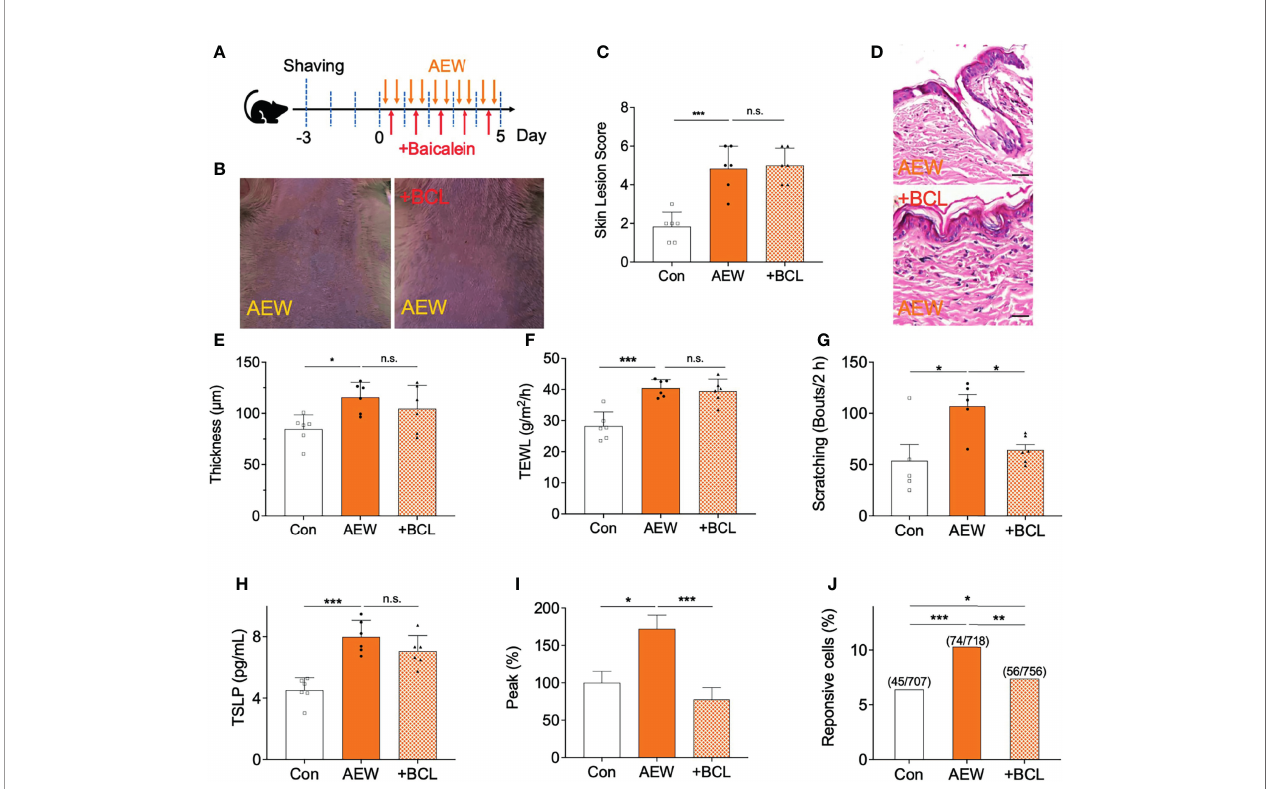
FIGURE 7 | Administration of a TSLPR antagonist reduced scratching behaviors in AEW-treated mice. (A) A schematic illustration depicting the administration of baicalein (BCL) during treatment with AEW. (B) Pretreatment with BCL did not alleviate the overall skin conditions following AEW treatment. (C) The skin lesion scores are not reduced in the BCL-treated AEW mice on day 5 (n = 6). (D) Representative H&E-stained images of the skin lesions of AEW-treated mice with or without BCL administration. (E) The thickness of the epidermis did not change in the skin lesions of the BCL-treated AEW mice (n = 6) (F) The values of TEWL were not altered in the BCL-treated AEW mice on day 5 (n = 6). (G) The spontaneous scratching bouts were signi fi cantly reduced in the BCL-treated AEW mice (n = 6), compared to those of the AEW mice (n = 6). (H) The serum levels of TSLP did not decrease in the BCL-treated AEW mice (n = 6), compared to those of the AEW- treated mice (n = 6). (I) The TSLP-induced responses of the DRG neurons from BCL-treated AEW mice (n = 56) revealed that the peak responses were signi fi cantly reduced in comparison to those of the AEW mice (n = 76). (J) The percentage of TSLP-responsive neurons in BCL-treated AEW mice (7.4%, 56 out of total 756 neurons) were signi fi cantly lower than those of the AEW mice (10.3%, 74 out of total 718 neurons) (Fisher ’ s exact test). * p < 0.05, ** p < 0.01, *** p < 0.001, n.s. not signi fi